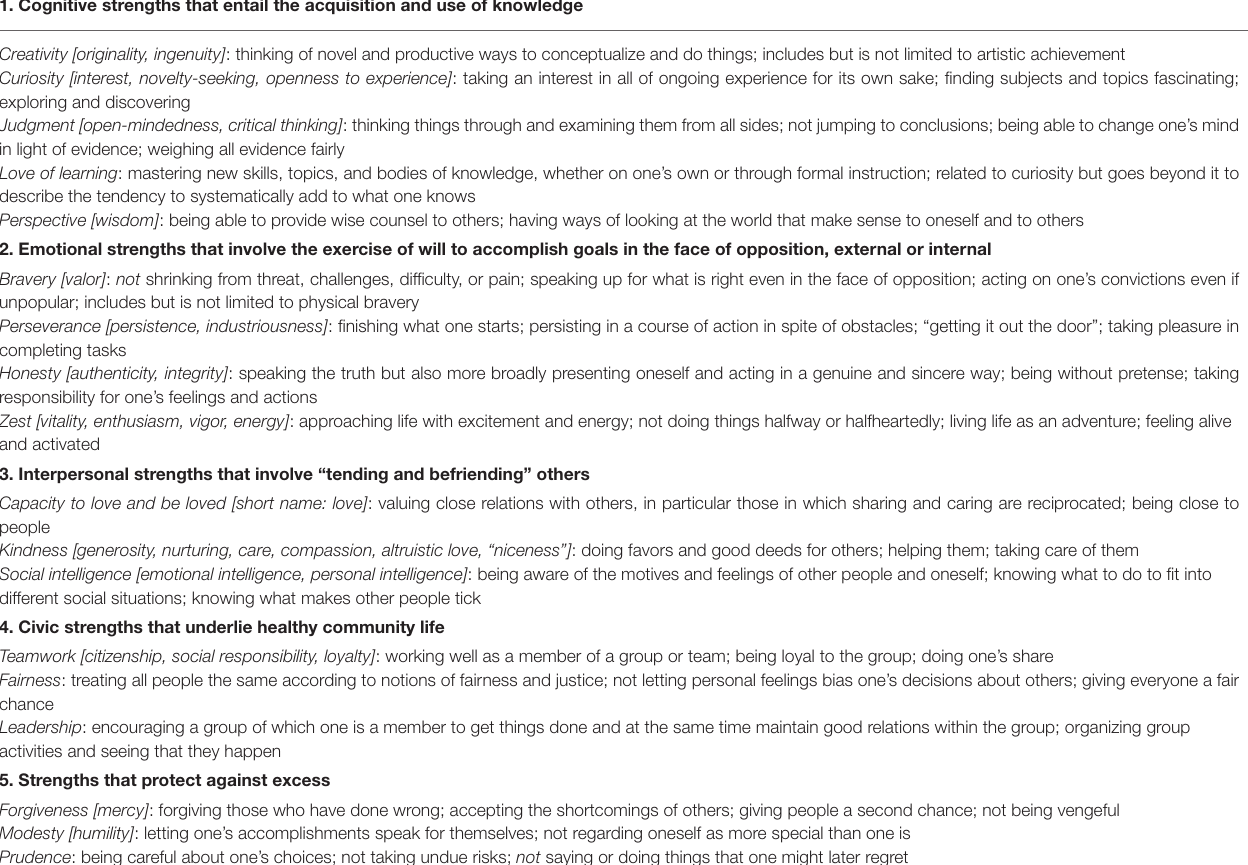
TABLE 1 | The 24 character strengths included in the Values in Action classification of strengths (Peterson and Seligman, 2004) and short descriptions defining the